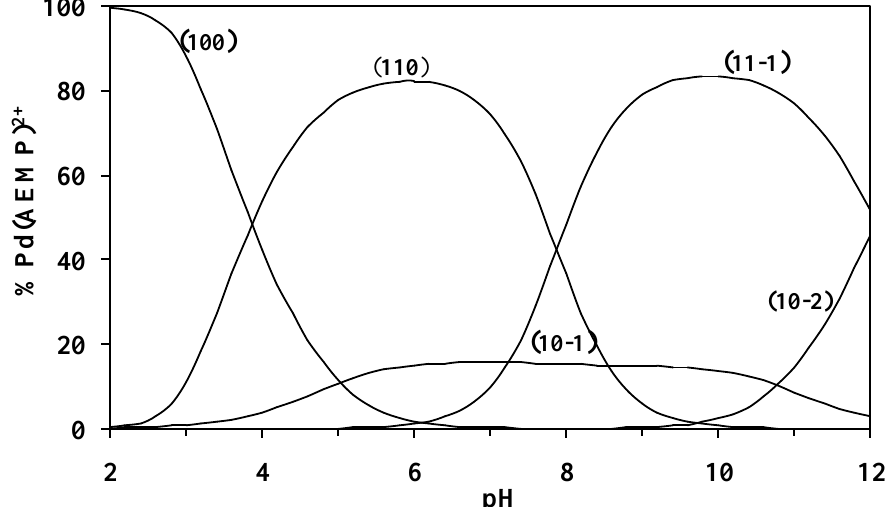
Figure 3. Concentration distribution of various species as a function of pH in the Pd(AEMP)- glycyl- glycine system at a concentration of 1.25 mM for [Pd(AEMP)(H 2 O) 2 ] 2+ and glyclglycine . The electronic absorption spectra of Pd(AEMP)-glycylglycine complexes were inves- tigated. Spectral bands of [Pd(AEMP)(H 2 O) 2 ] 2+ and its glycylglcine (Glygly) complex are quite different in the position of the maximum wavelength, see Figure 4. The spectral band of the [Pd(AEMP)(H 2 O) 2 ] 2+ complex (A) showed up at 360 nm, and is shifted to 325 nm upon formation of the [Pd(AEMP)(Glygly)] + complex (B). A further shift of the band to 313 nm appeared under deprotonation and formation of the [Pd(AEMP)(Glygly-H)] com- plex (C). The progressive shift toward a shorter wavelength in the absorption spectrum, may indicate evidence for the induced ionization of the amide proton upon complex for- mation. This is supported by the potentiometric measurements for the coordination scheme of peptides. There is no significant absorption for glycylglycine in this spectral region.